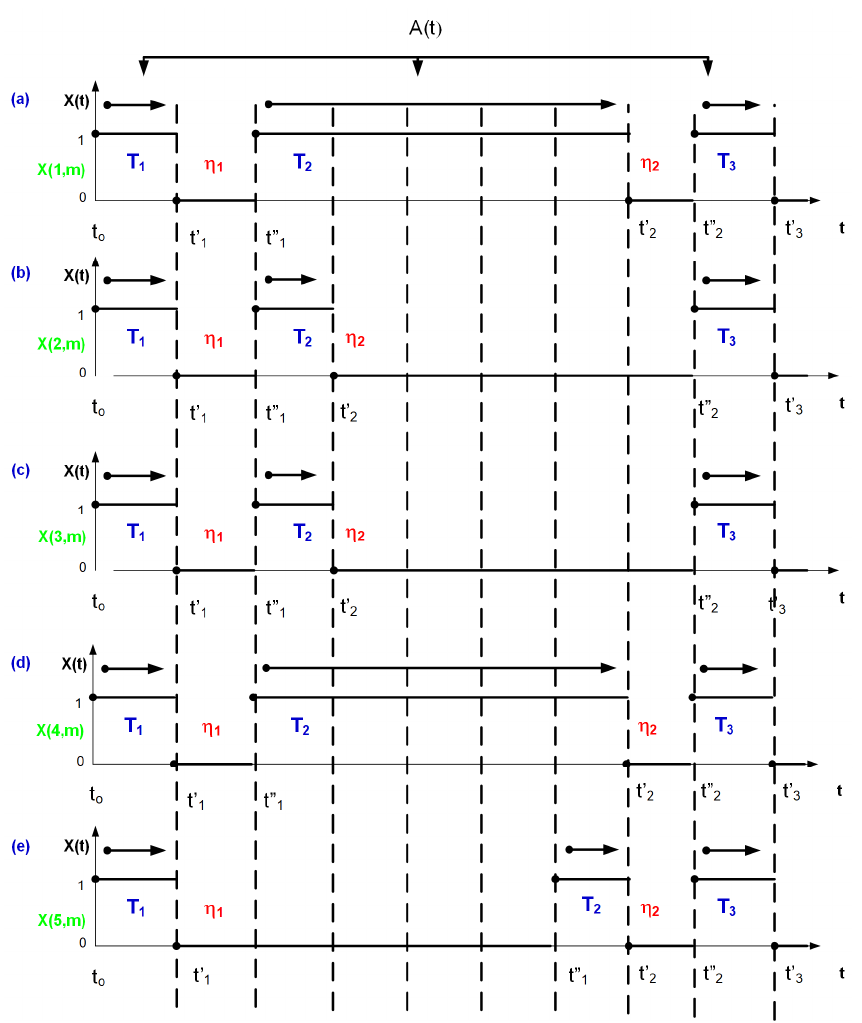
Figure 4. A graphic presentation of the process of damaging the AIS service structure (prepared by the author). Where: navigation parameters for M data streams ( a ) POS, ( b ) ROT, ( c ) HDG, ( d ) SOG, ( e ) COG.